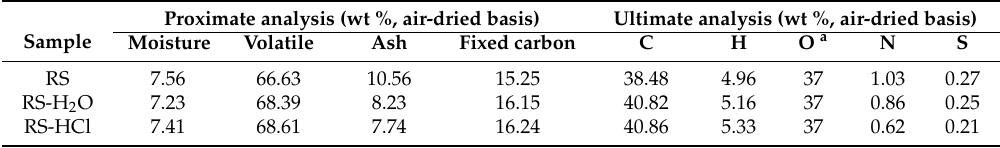
Table 1. Ultimate and proximate analysis of the samples. RS: rice straw.